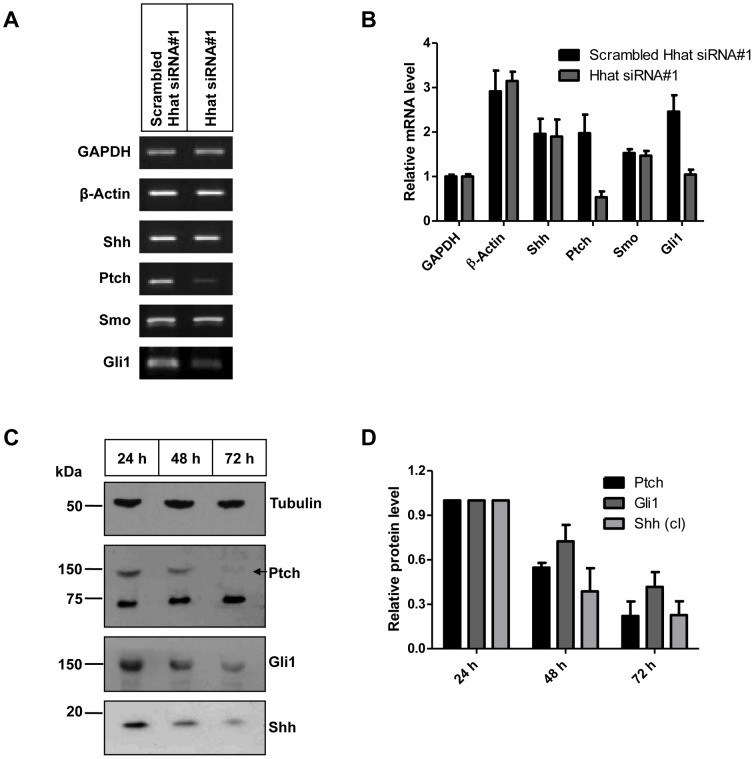
Hhat KD reduces Shh signaling in PANC1 cells.To study the role of Hhat in Shh signaling, expression levels of Shh targets Ptch and Gli1 were examined by both RT-PCR and Western blot after Hhat-#1 KD (A, C). Quantification of results is provided in B and D. Interestingly, cell-associated Shh protein is reduced by Hhat-#1 KD (C, bottom panel) but Shh mRNA level is unchanged (A), suggesting that Hhat-#1 KD reduces Shh retention by cells. In combination, this suggests that un-palmitoylated Shh has less ability to associate to cell membranes, but instead is released to the medium.